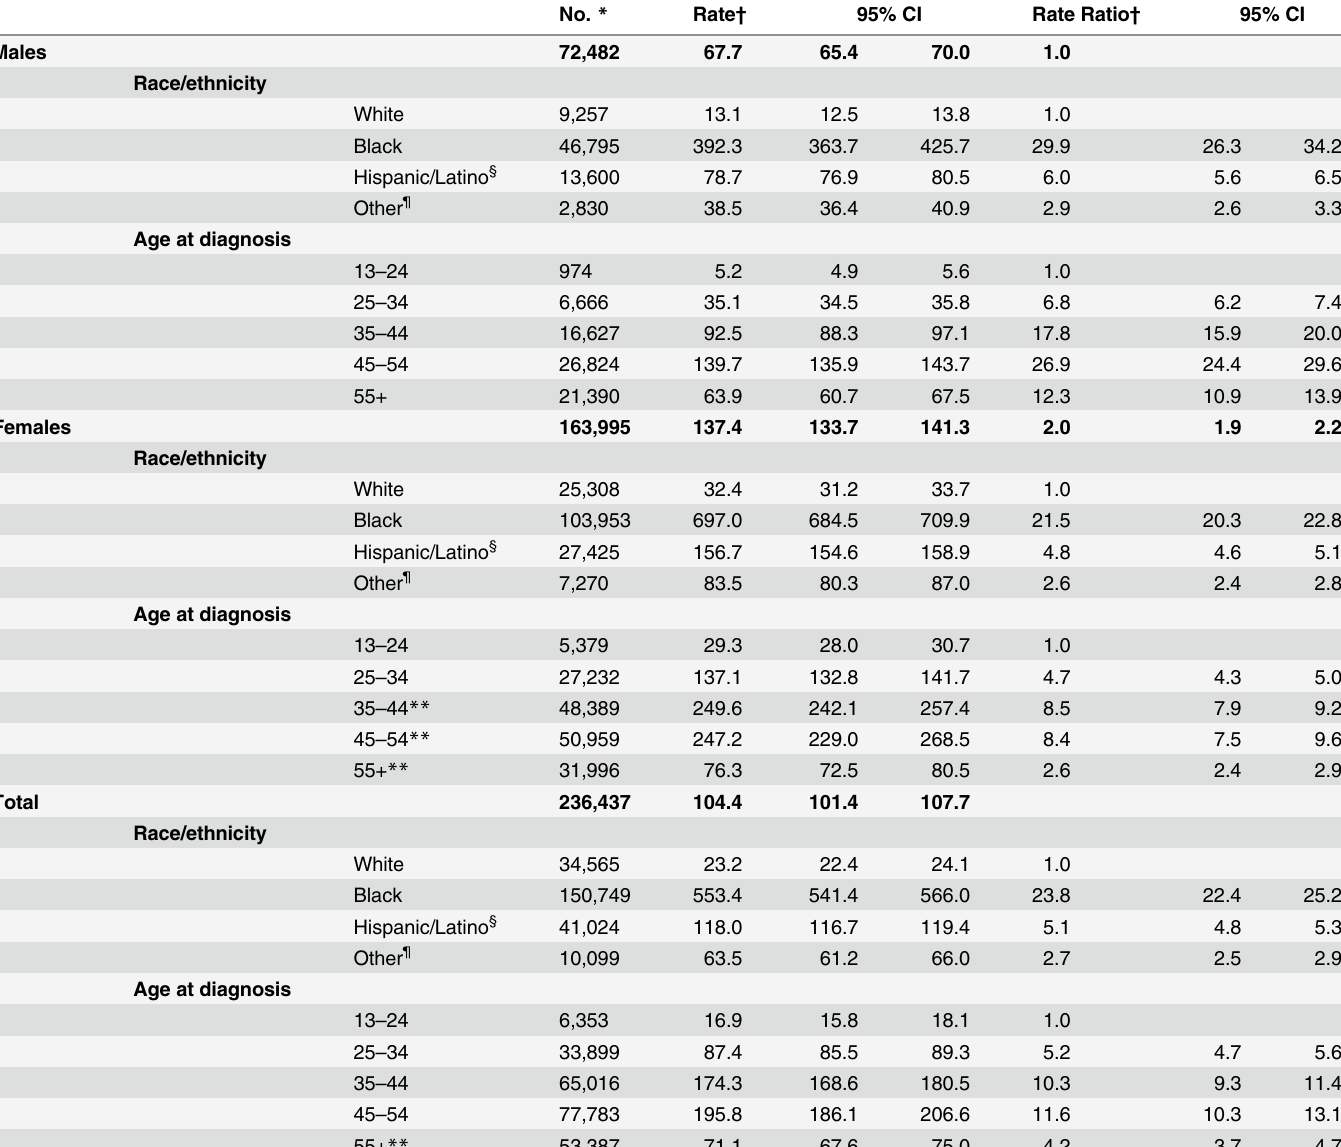
Table 5. Adult and adolescent heterosexuals living with diagnosed HIV infection- United States, 2012. Note. Data include persons age 13 years and older with a diagnosis of HIV infection regardless of stage of disease at diagnosis. CI = confidence interval No. * Rate † 95% CI Rate Ratio † 95% CI Males Race/ethnicity